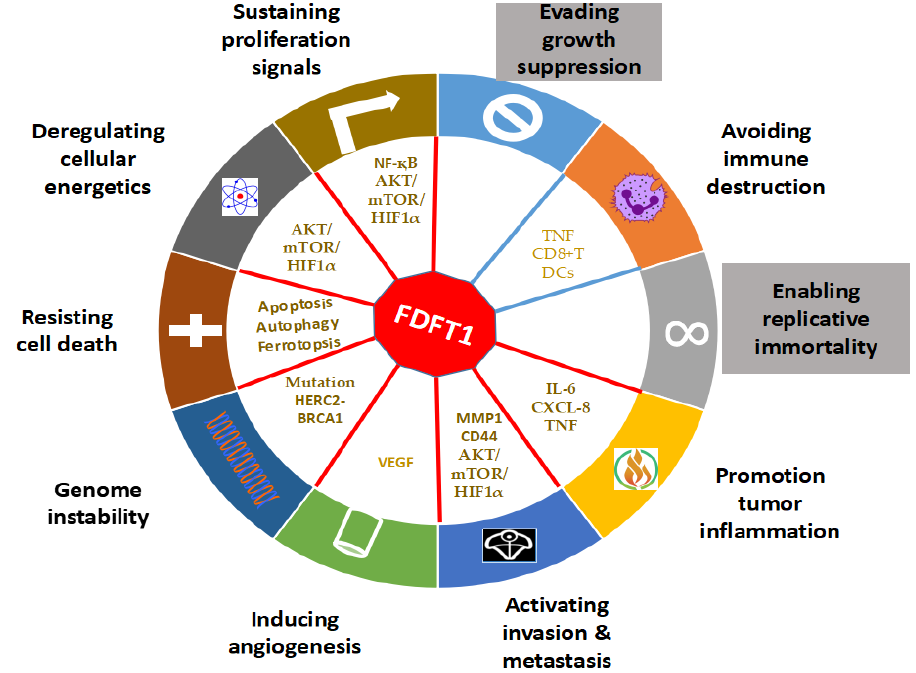
Figure 3. Hallmarks of cancer. Hallmarks of cancer include inappropriately sustained proliferation signals, resistance to cell death, escape from growth suppression, possible replication immortality, invasion and metastasis, inflammation promotion of cancer, avoidance of immune destruction, genetic instability and mutations, and remodelling of cellular metabolism. Seven of the cancer hallmarks originate from tumour cells themselves, while the rest are involved in the tumour microenvironments (TME).